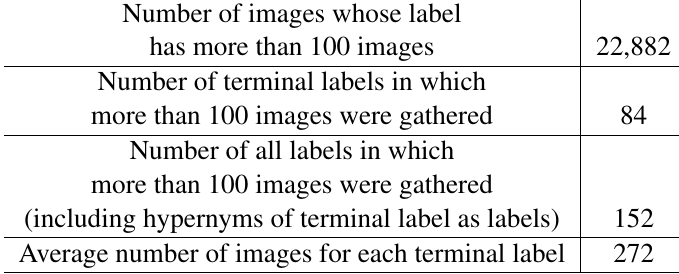
Table 1. Statistical information about the generated hierarchic image database for labels that have more than 100